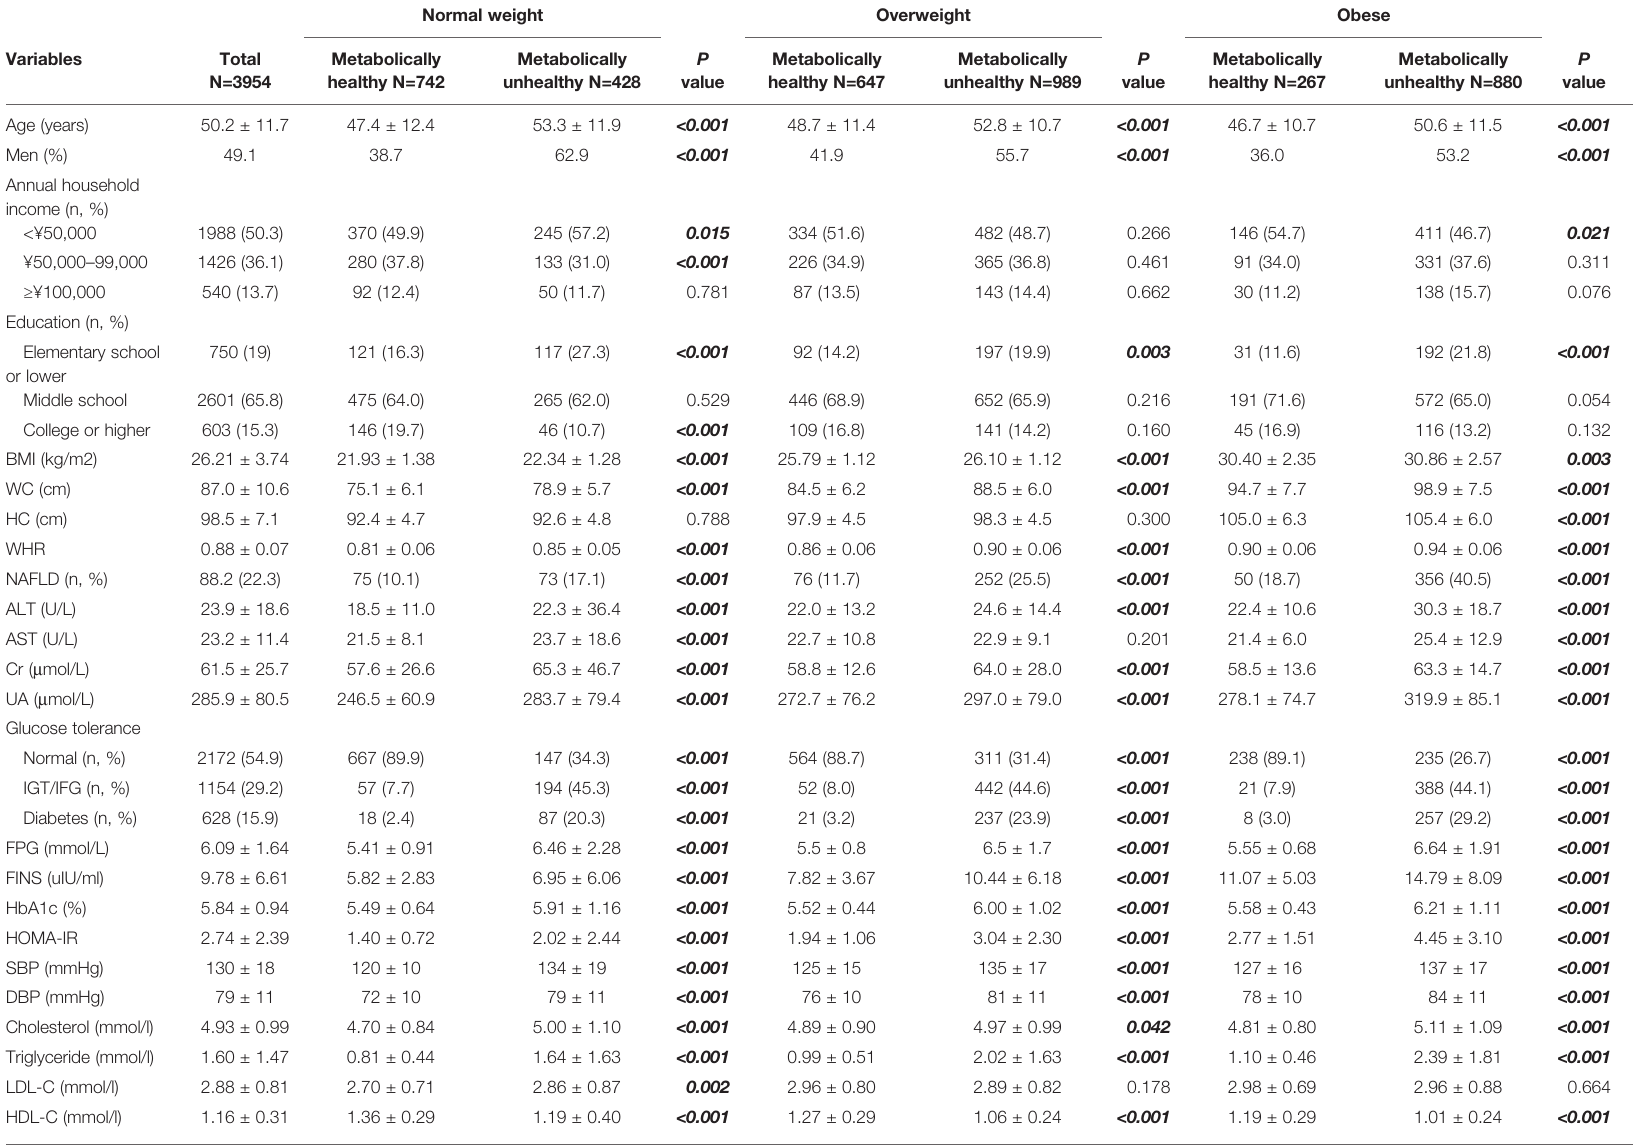
TABLE 1 | Demographic and clinical characteristics of study